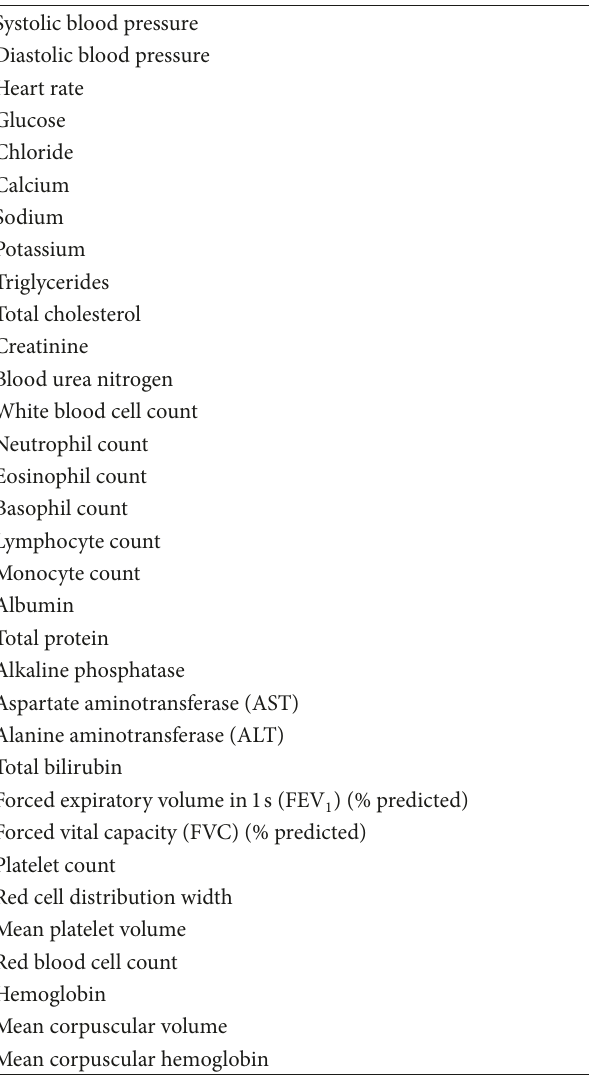
Table 1: Candidate physiological parameters considered for inclu- sion in WTC